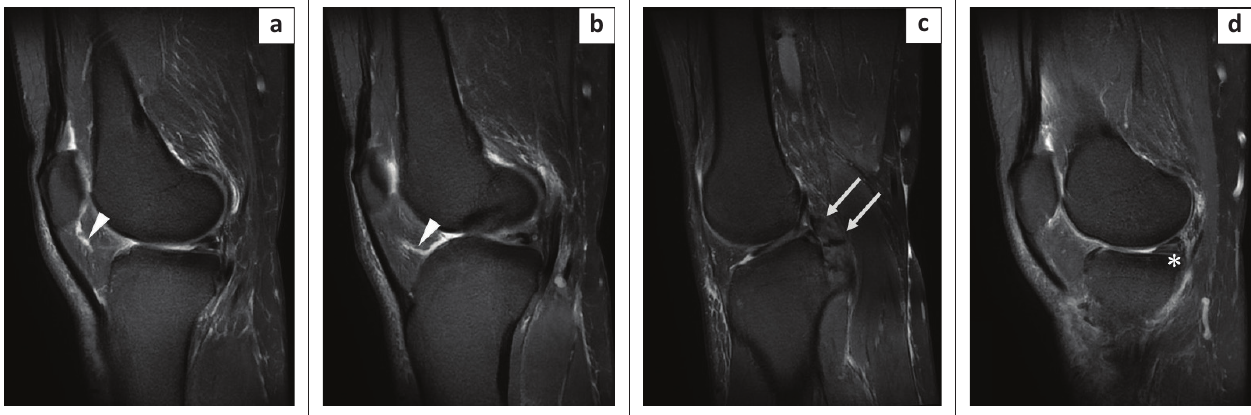
FIG URE 8: Magnetic resonance imaging of an infrapatellar plica tear in a 46-year-old male with a history of falling from a bike and knee pain: Serial oblique sagittal PDFS images (a) and (b) demonstrate a hyperintense fluid collection along the entire course of infrapatellar plica (arrow heads), with ragged margins. Oblique sagittal PDFS image (c) revealed that the patient also had an avulsion injury of the posterior cruciate ligament (arrows). Sagittal PDFS (d) indicated a complex tear of the posterior horn of the medial meniscus (asterisk).